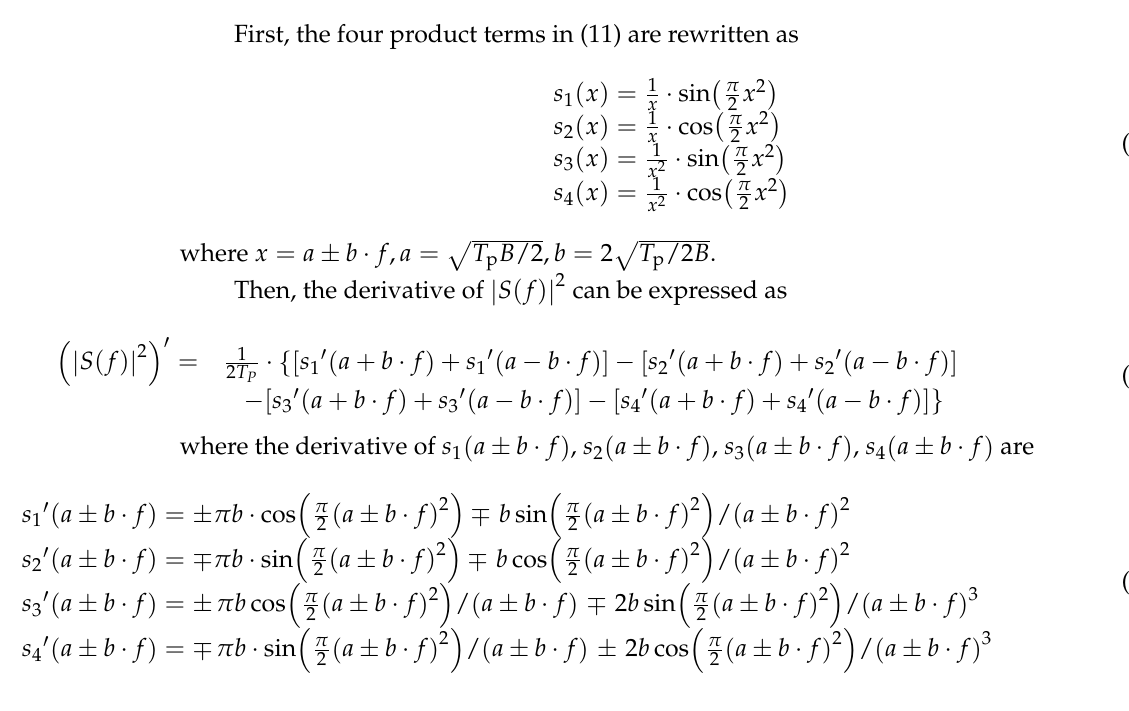
Figure 8. Amplitude of synthesized wideband spectrum and corresponding HRRPs: ( a ) synthesized wideband spectrum with the continuous sinusoidal amplitude; ( b ) synthesized wideband spectrum with the discontinuous sinusoidal amplitude; ( c ) HRRP with the continuous sinusoidal amplitude spectrum; ( d ) HRRP with the discontinuous sinusoidal amplitude spectrum.